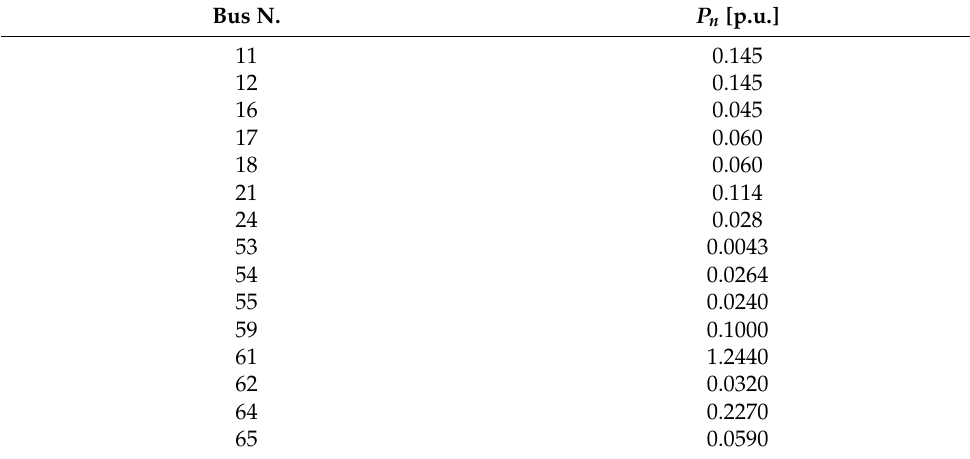
Table 1. Injection Buses. Bus N.